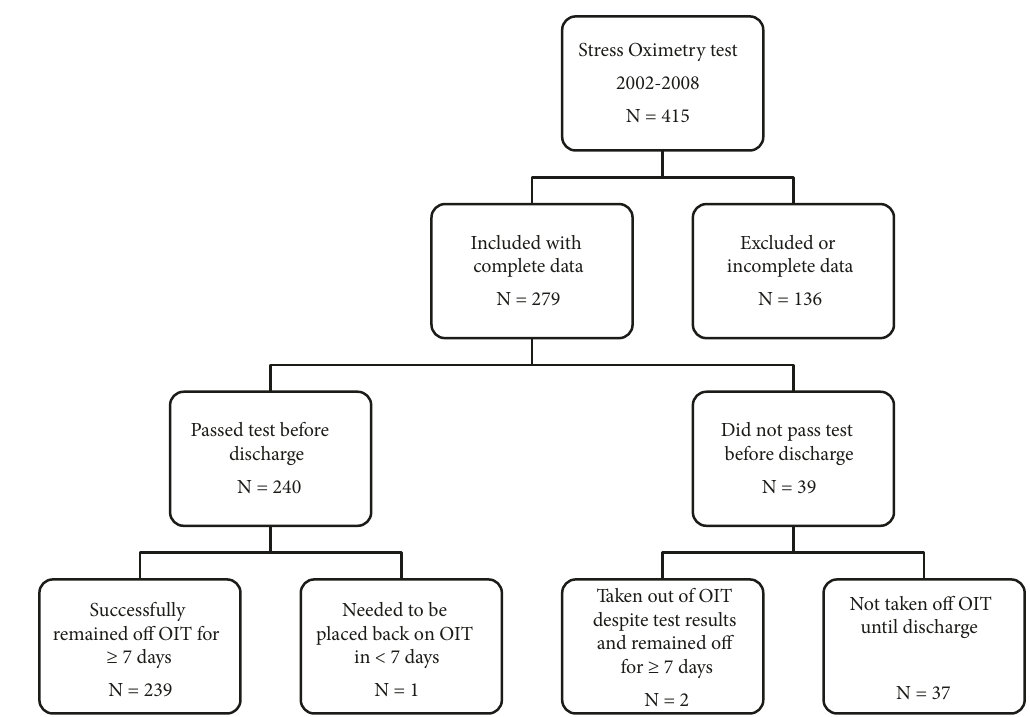
Figure 2: Patients with “Stress Oximetry